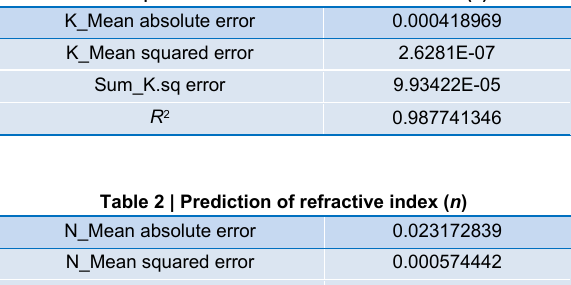
Table 1 | Prediction of extinction coefficient ( k ).